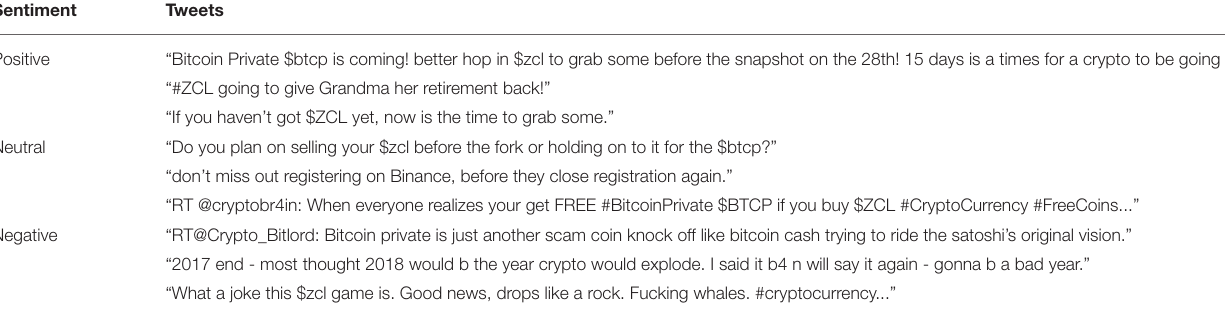
TABLE 2 | Examples of Tweets with positive, neutral and negative sentiment classifications in our dataset. Sentiment